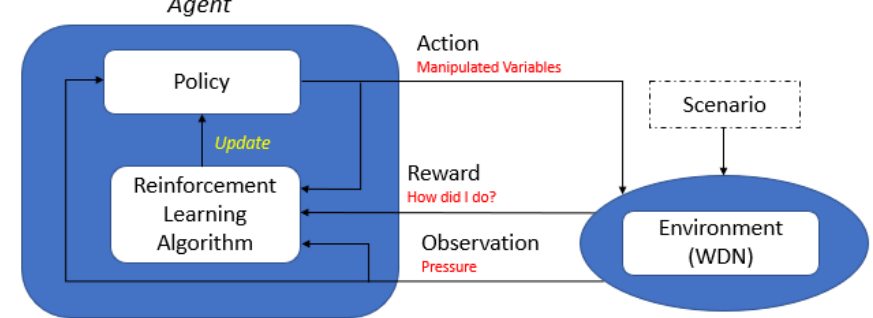
Figure 1. Reinforcement learning